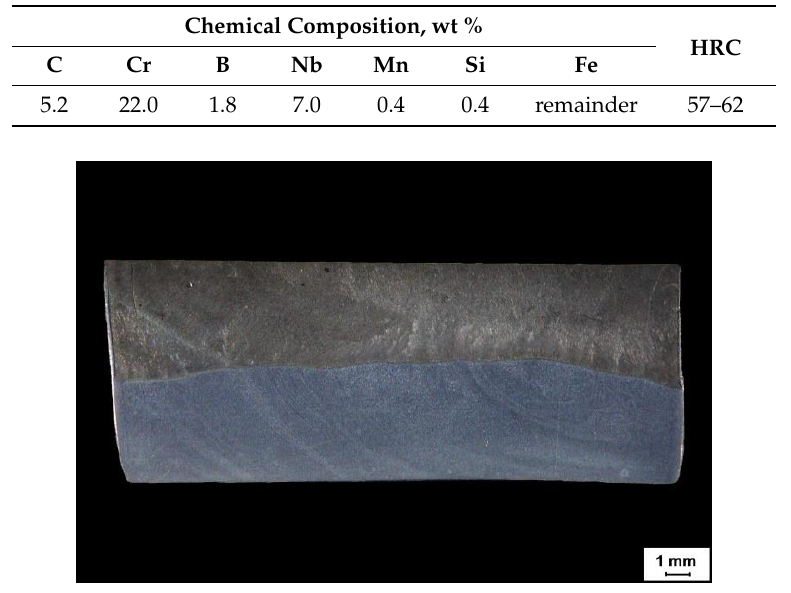
Figure 3. Macrostructure of a cross-section of CDP plate.